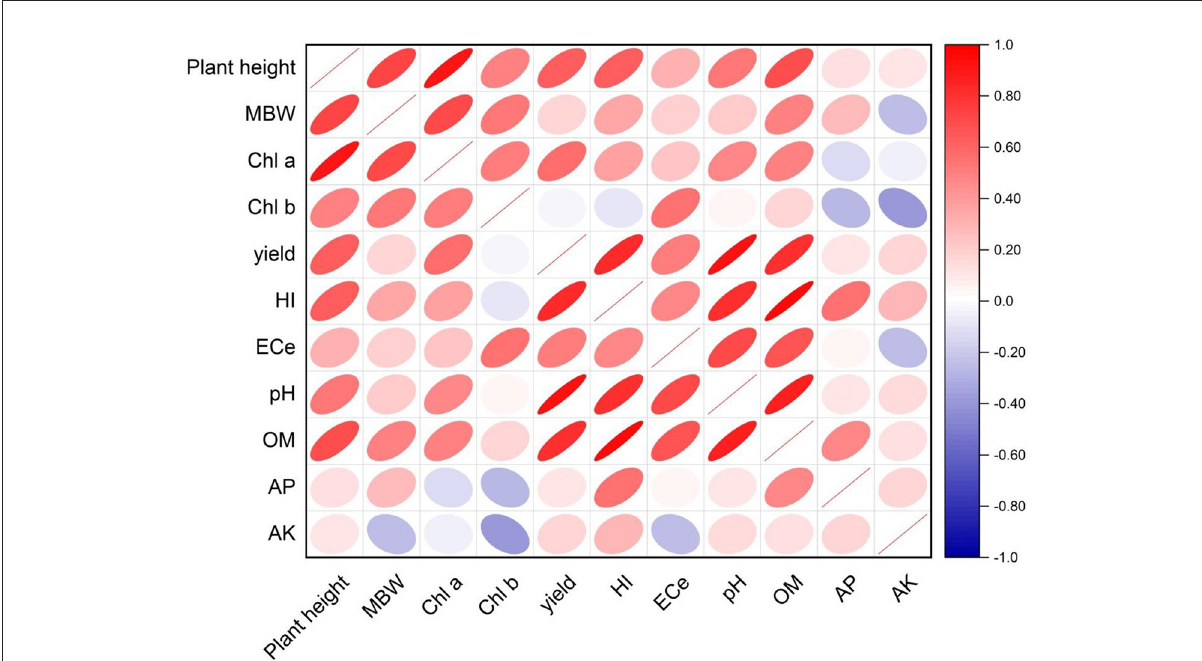
FIGURE6 Correlation of growth, yield, and physiological attributes of the cotton crop, yield components of legume intercrops, and soil health indicators under different tillage systems and legume intercrops; the areas of circles show the absolute value of corresponding correlation coefficients tested at the * 0.01 significant level. PH, Plant height; TB, Total bolls per plant; MBW, Mean boll weight; Chl a, chlorophyll a; Chl b, chlorophyll b; Yield, seed cotton yield; HI, harvest index; ECe, electrical conductivity; pH, soil pH; OM, organic matter; AP, soil available phosphorus; AK, soil available